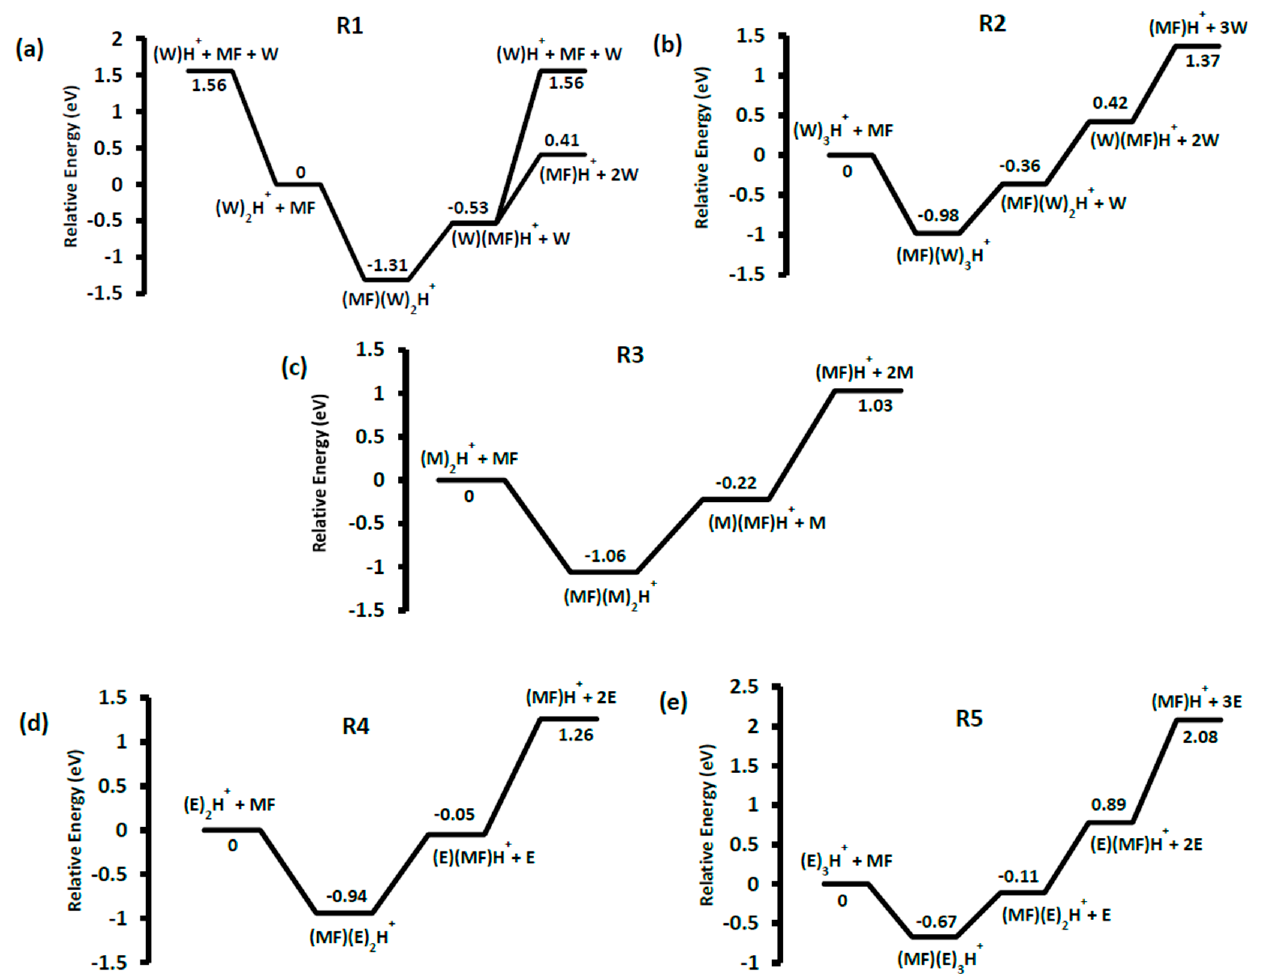
Figure 2. Relative energy (B3LYP/6-311+G(d,p)) of the major product ions resulting from the reaction between neutral methyl formate with ( a ) the water cluster dimer and ( b ) the water cluster trimer, ( c ) the methanol dimer, ( d ) the ethanol dimer and ( e ) the ethanol trimer.